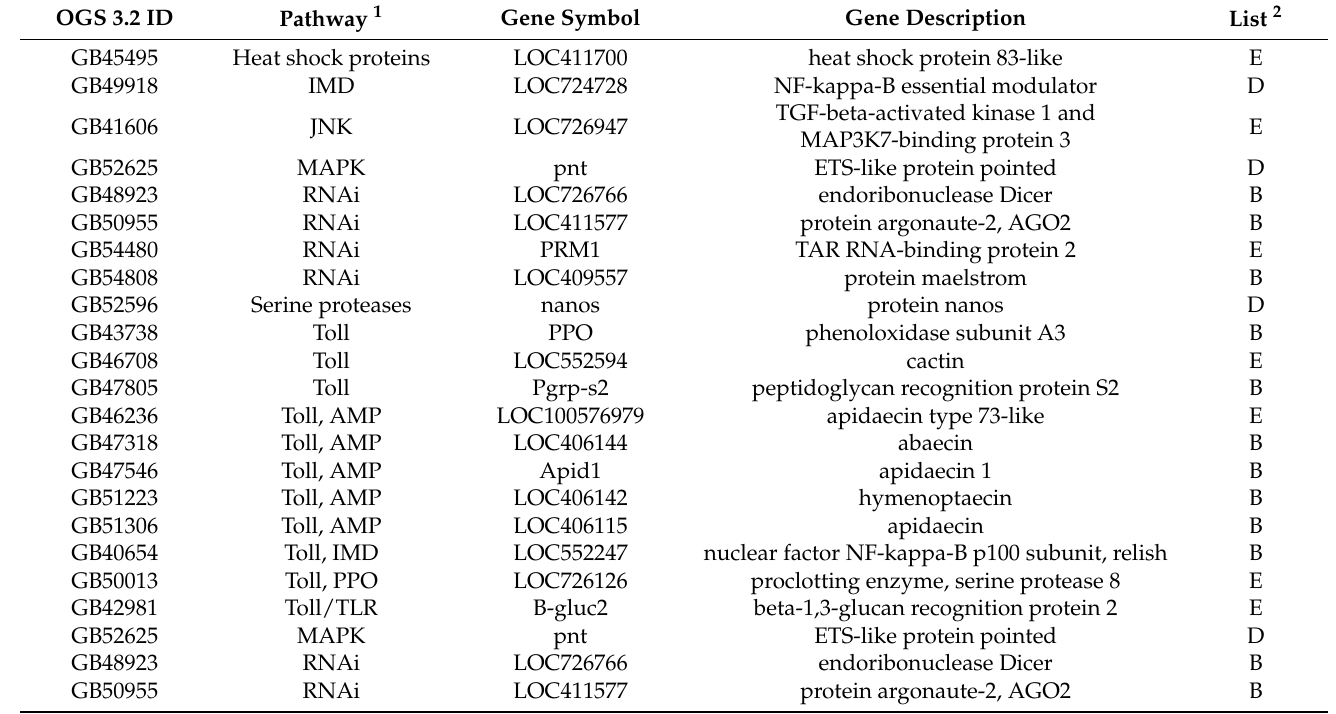
Table 3. Upregulated immunity genes.